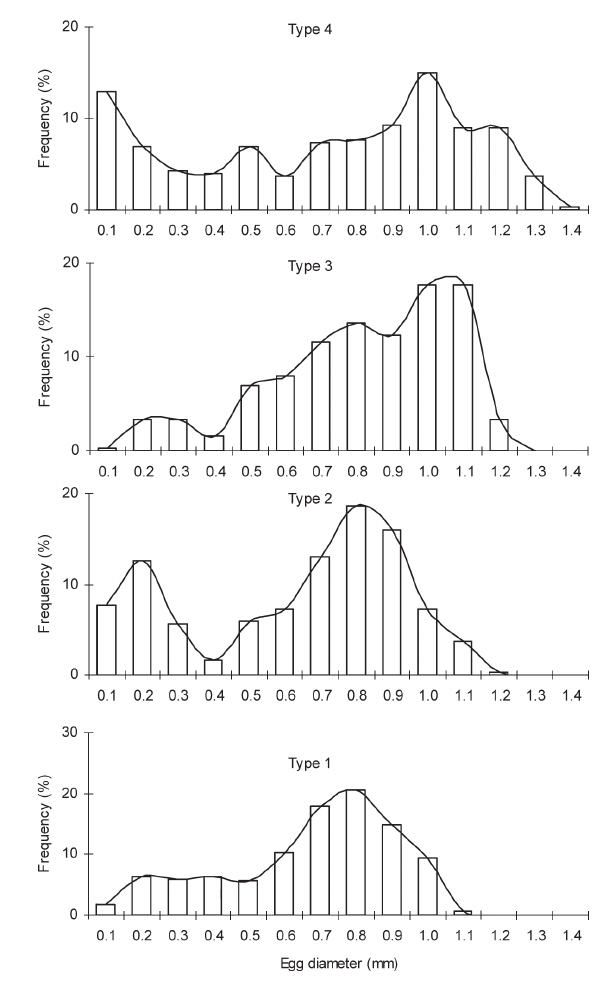
Fig. 2. Oocyte size distribution of pre-spawning female discus Symphysodon aequifasciatus captured in November 2006 in Ayapuá Lake (AM) showing four types of egg